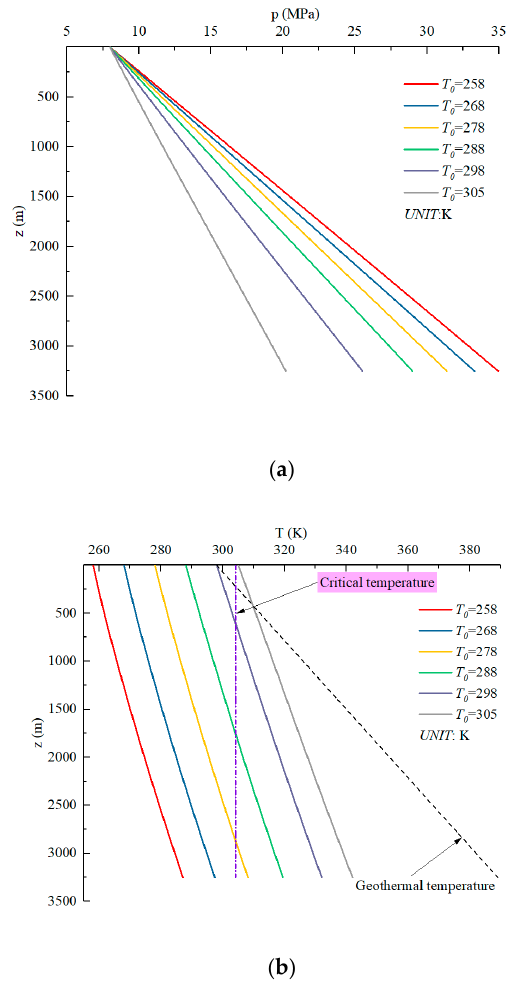
ff ect of injection temperature: ( a ) CO Figure 11. Effect of injection temperature: (a) CO 2 pressure profile; (b) CO 2 temperature profile. Figure 11. E